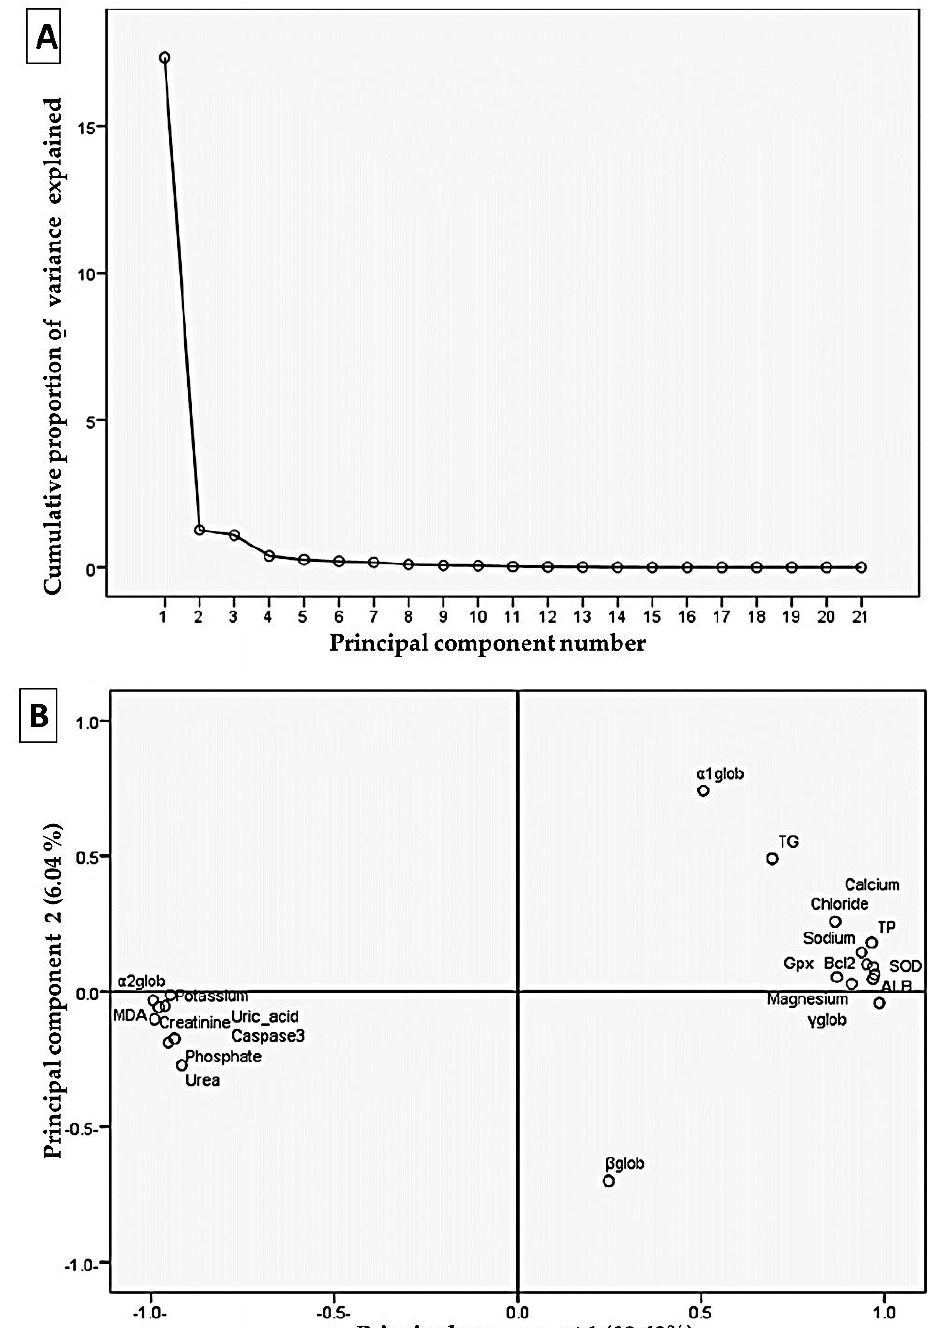
Figure 6. Principal component analysis plot showing the relationships among the estimated variables. ( A ) Cumulative proportion of variance as a function of the number of principal components (PC). ( B ) All of the biochemical indicators plotted as a function of PC1 and PC2, which account for 82.48% and 6.04% of the variance, respectively. TB: total protein; TG: total globulin; ALB: albumin; Gpx: glutathione peroxidase; SOD: superoxide dismutase; and MDA: malondialdehyde.